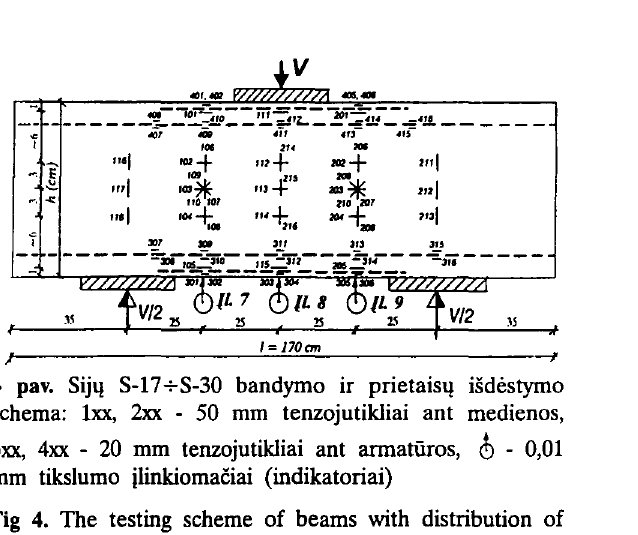
Fig 4. The testing scheme of beams with distribution of devices: 1XX, 2XX - 50 mm long strain gauges located on timber, 3XX, 4XX - 20 mm long strain gauges located on reinforcing steel, 6 - deflection indicators within pre cision of 0,01